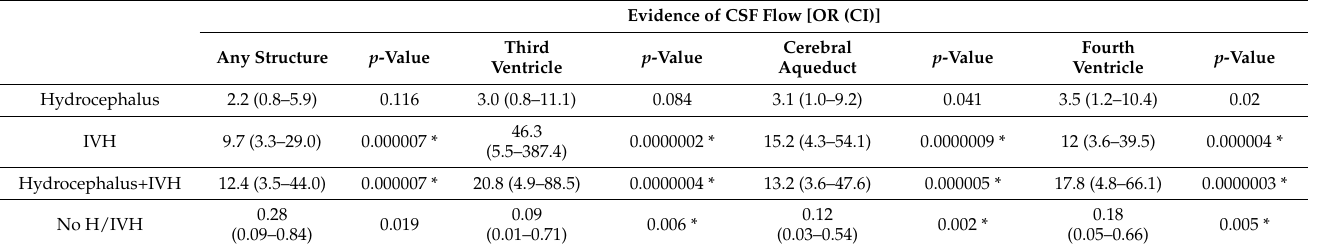
Table 2. Detection of CSF flow between